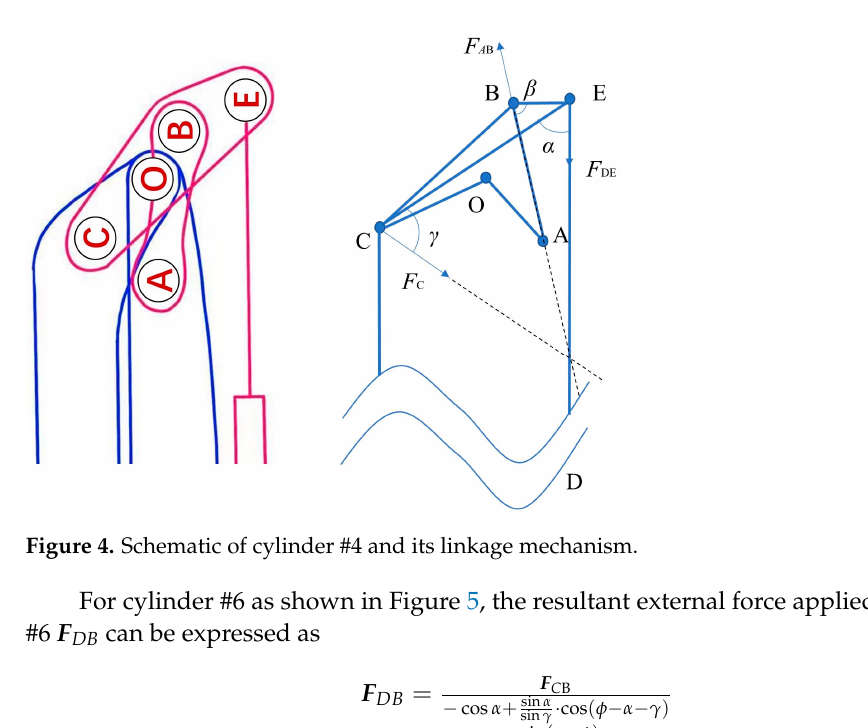
6 of 26 Figure 3. Schematic of cylinder #i (i = 2, 3, 5) and its linkage mechanism. For cylinder #4 as shown in Figure 4, the resultant external force applied on cylinder #4 F DE can be expressed as